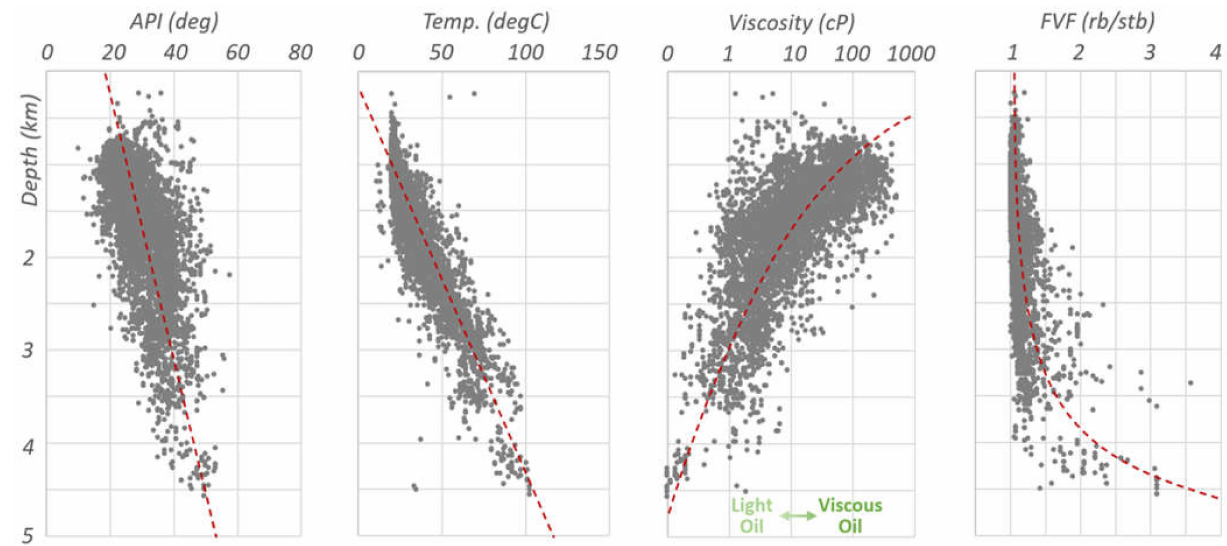
Figure 18. API, temperature, viscosity and FVF trends with depth in Basin X